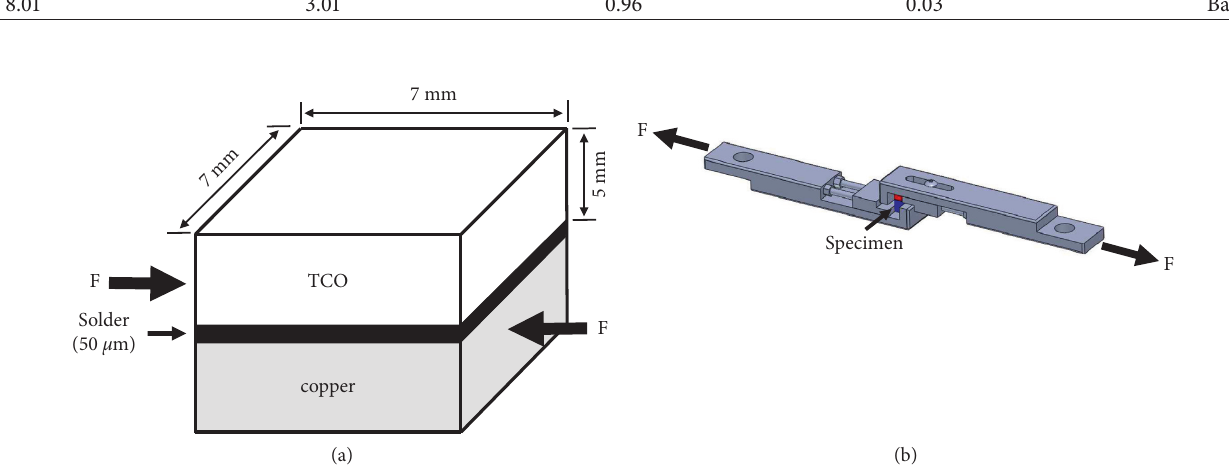
Figure 1: The geometry and dimensions of the joints subjected to shear testing. (a) Schematic representation of the soldered specimen. (b) Schematic representation of the grips for tensile shear testing.